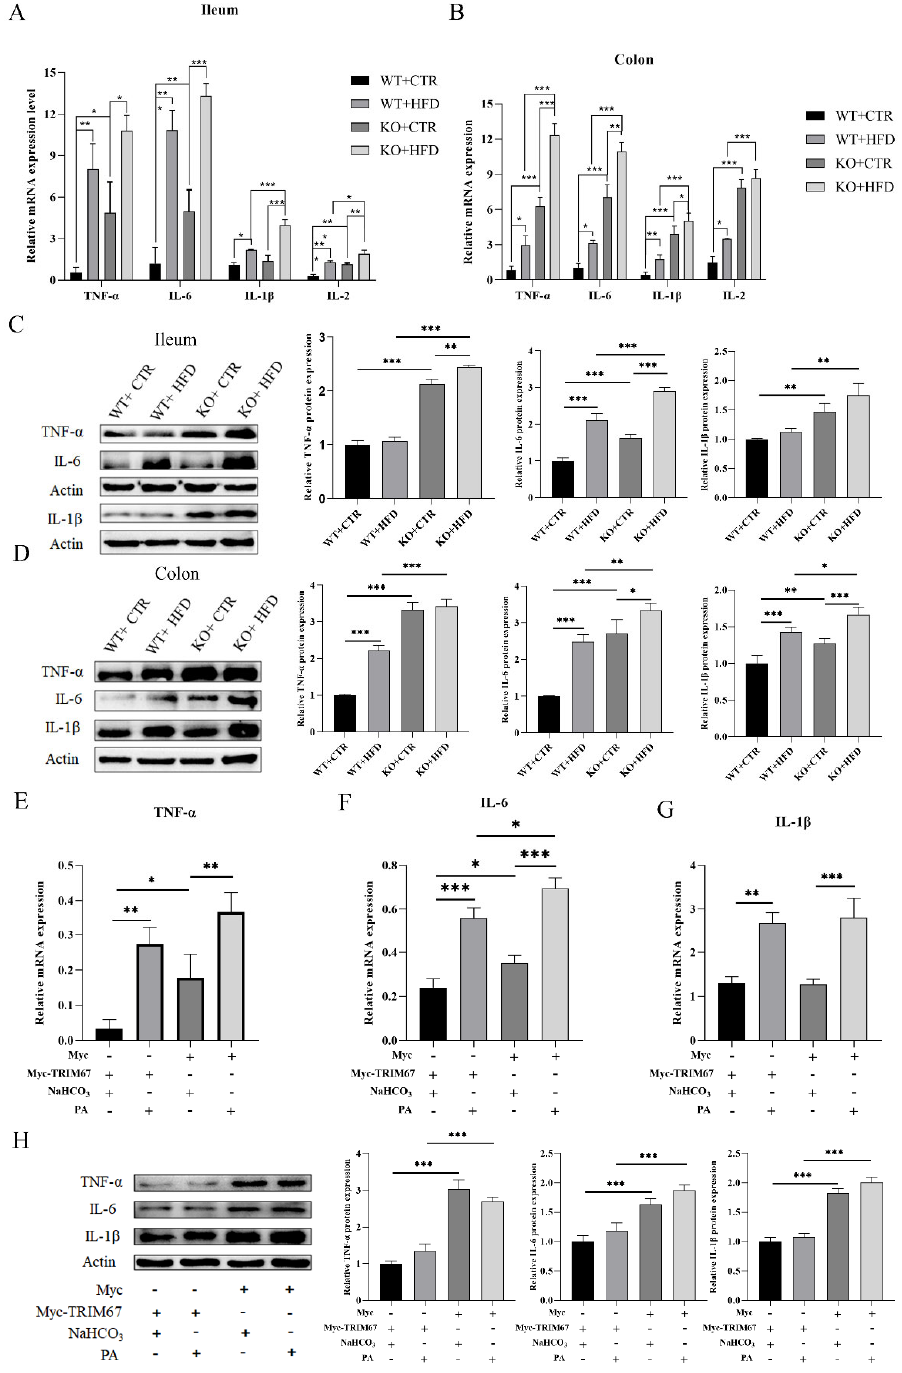
Figure 5. TRIM67 deletion represents the overexpression of pro-inflammatory cytokines in ileum and colon. ( A , B ) Relative mRNA expression of TNF- α ( n = 5), IL-6 ( n = 5), IL-1 β ( n = 4) and IL-2 ( n = 4) in ileum and colon. ( C , D ) Western blots and quantification to check protein level of TNF- α , IL-6, and IL-1 β in ileum and colon ( n = 3). ( E – G ) Relative mRNA expression of TNF- α , IL-6 , and IL-1 β in Myc-TRIM67 and Myc cell lines supplemented with NaHCO 3 and PA, “-”: no addition, “ + ”: addition ( n = 4). ( H ) Western blots and quantification display the protein level of TNF- α , IL-6, and IL-1 β in Myc and Myc-TRIM67 groups supplemented with NaHCO 3 and PA, “-”: no addition, “+”: addition ( n = 3). The data are expressed as mean ± SEM. Significance was determined by one-way ANOVA (* p < 0.05, ** p < 0.01, *** p <